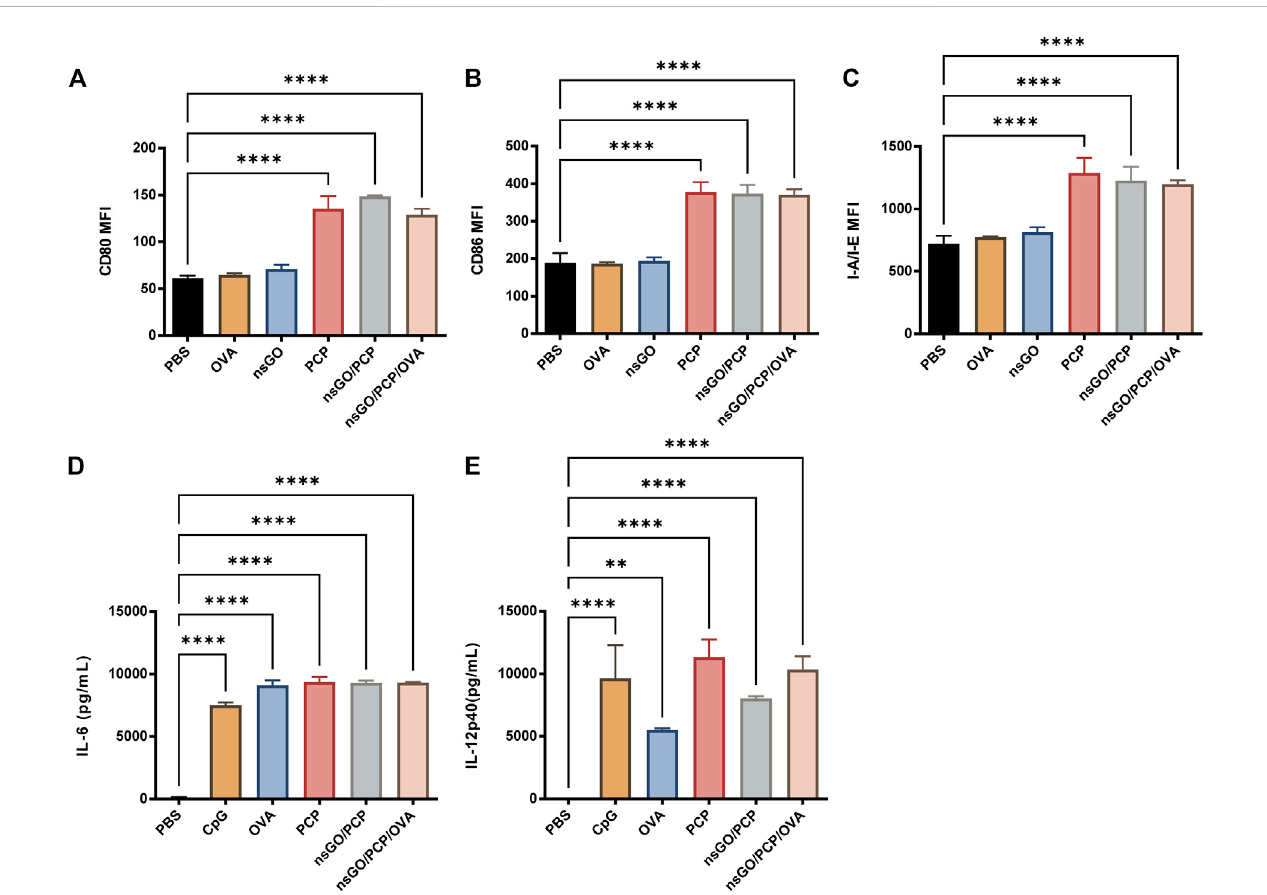
FIGURE 2 In vitro BMDC maturation induced by nsGO/PCP/OVA. Immature BMDCs were isolated from C57BL/6 female mice and stimulated with 20 μ g/mL OVA, 5 μ g/mL nsGO, 100 μ g/mL PCP, nsGO/PCP, and nsGO/PCP/OVA for 24 h. Expression of BMDC surface markers CD80 (A) , CD86 (B) , and I-A/I-E (C) were analyzedby fl owcytometry.SupernatantofBMDCculturewascollected,IL-6 (D) andIL-12 (E) secretionbyBMDCswasmeasuredbyELISA.Valuespresented are the means ± SD of three replicates, **, p < 0.01; ****, p < 0.0001 vs. PBS